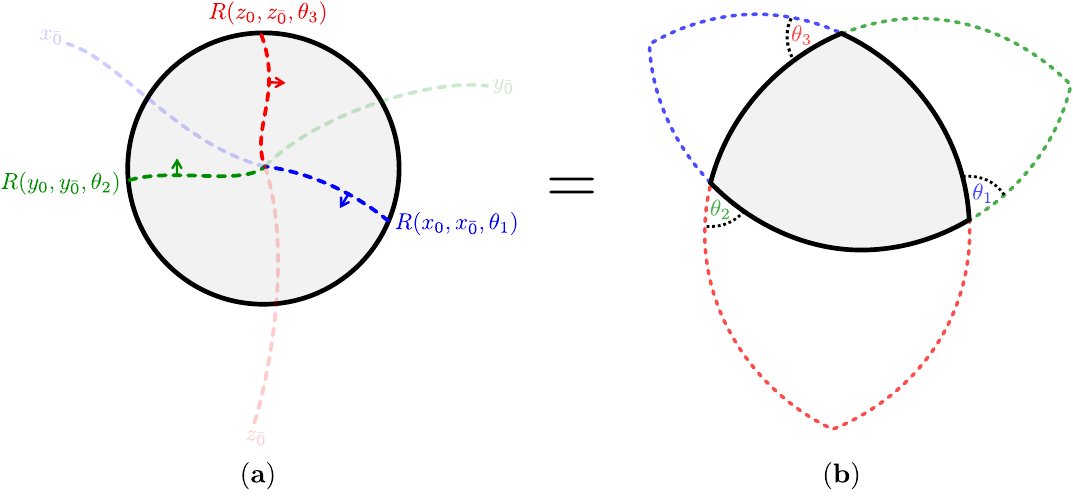
Figure 5 . ( a ) A circular Wilson loop with three colour-twist insertions at three points along the loop x 0 , y 0 , and z 0 . The three twist transformations map the plane of the loop to itself. They have two (cid:12)xed points each, given by ( x 0 ; x (cid:22)0 ), ( y 0 ; y (cid:22)0 ), and ( z 0 ; z (cid:22)0 ). Near these points, they act as rotations by three angles (cid:18) 1 , (cid:18) 2 , and (cid:18) 3 , respectively. The points along the loop and the angles are arbitrary. The points x (cid:22)0 , y (cid:22)0 , and z (cid:22)0 are (cid:12)xed by the monodromy condition R ( z 0 ; z (cid:22)0 ; (cid:18) 3 ) :R ( y 0 ; y (cid:22)0 ; (cid:18) 2 ) :R ( z 0 ; z (cid:22)0 ; (cid:18) 1 )=1. This correlator is equivalent to a Wilson loop with three cusps of angles (cid:18) 1 , (cid:18) 2 , (cid:18) 3 and no colour-twists insertions that is plotted in ( b ). It is built from three circular arcs. One arc (say, the arc connecting z 0 and x 0 ) can be chosen to be a part of the initial cir- cle, the other two are obtained as a result of the action of R ( z 0 ; z (cid:22)0 ; (cid:18) 1 ) and R ( z 0 ; z (cid:22)0 ; (cid:18) 1 ) :R ( y 0 ; y (cid:22)0 ; (cid:18) 2 ) on arcs of the initial circle (the ones connecting x 0 with y 0 and y 0 with z 0 , respectively). The set-up on the (cid:12)gure ( b ) was studied in [9, 10] in the ladders